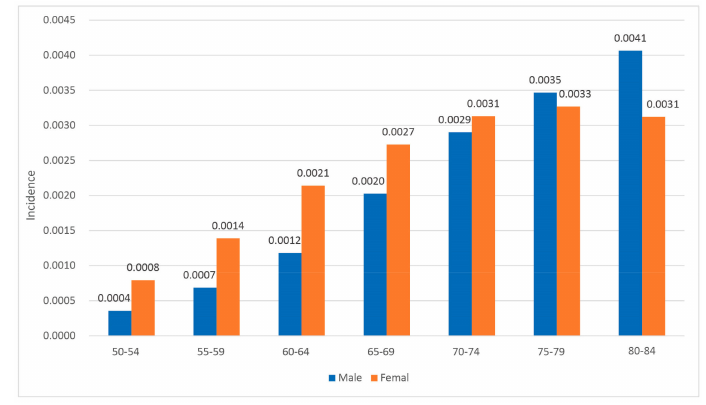
Figure 4. Incidence of lung cancer in male and female age